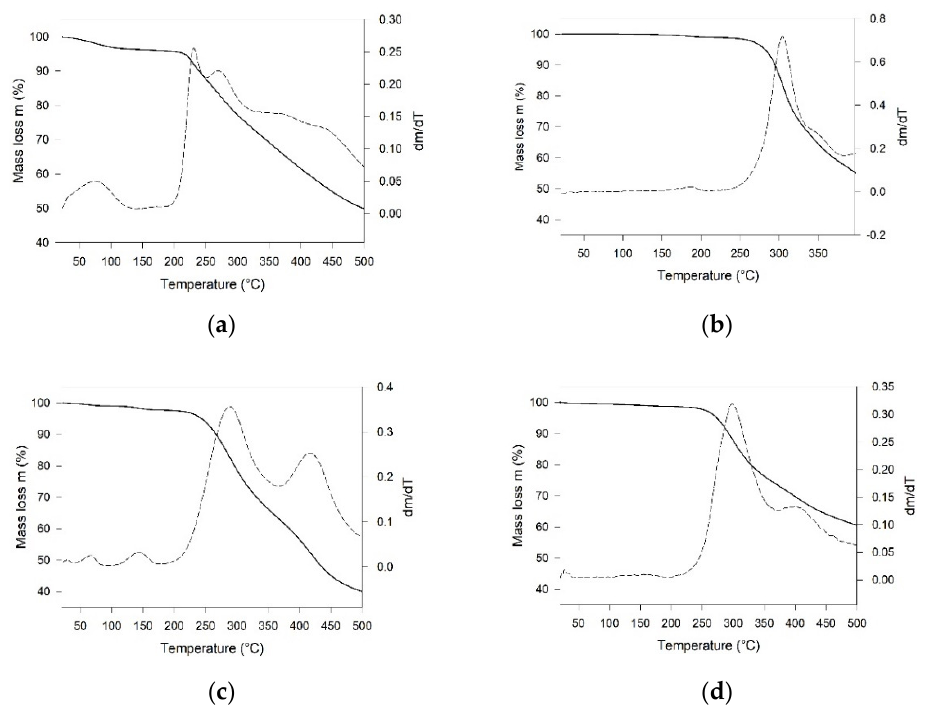
Figure 3. Thermogravimetric (solid line) and DTG curves (dashed line) for ( a ) Fura, ( b ) m -xy, ( c ) p -xy, and ( d ) diphen cages.